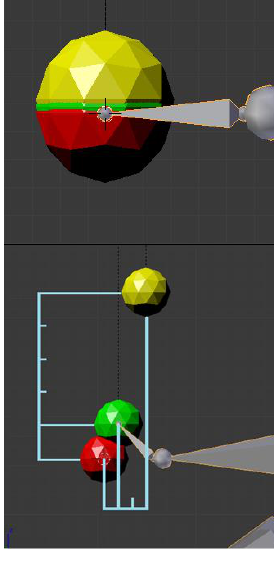
Figure 3. Visualisation of motion amplification. Red sphere = resting position, green sphere = user’s movement, yellow sphere = amplified movement. Upper image: the user’s hand is resting. Lower image: the user raised his hand, which shall correspond to an arm movement.